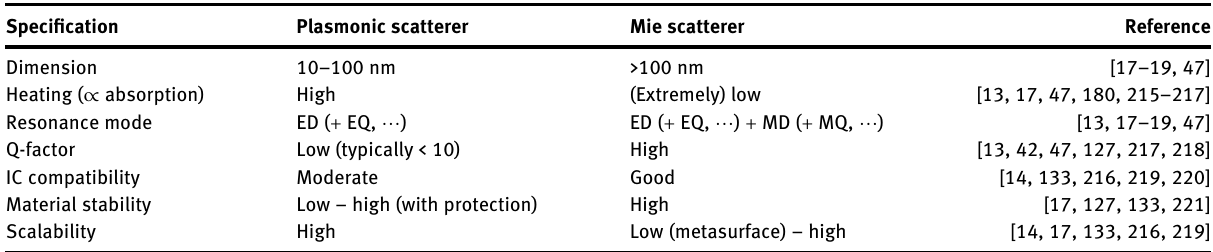
Table  : Features of plasmonic and Mie scatterers (ED: electric dipole, EQ: electric quadrupole, MD: magnetic dipole, MQ: magnetic